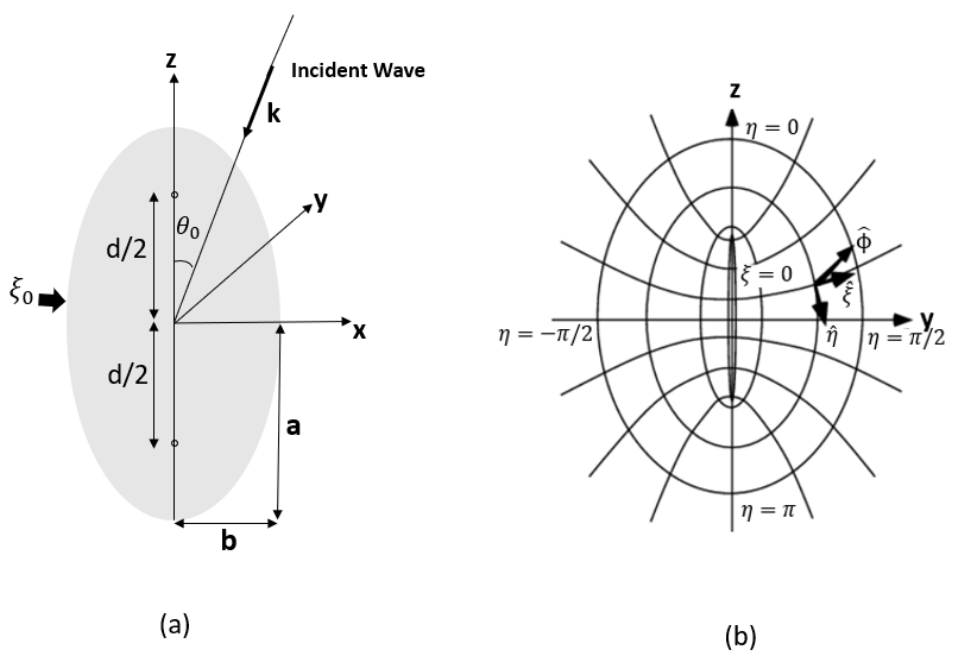
Figure 1. Prolate spheroid geometry ( a ) and the spheroidal coordinate system ( b